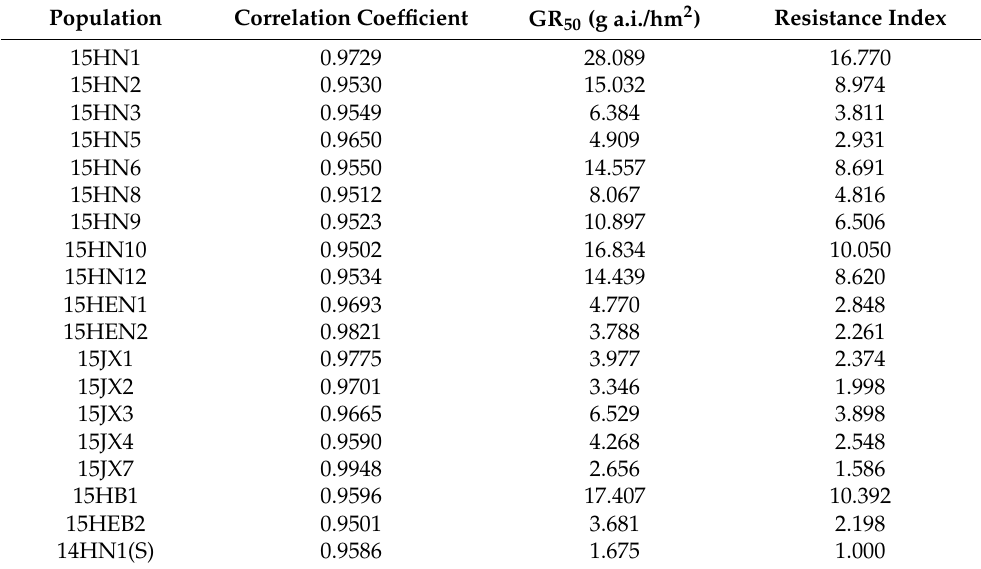
Table 2. The different resistance levels of D. sanguinalis populations to haloxyfop-P-methyl in cotton fields (2015).